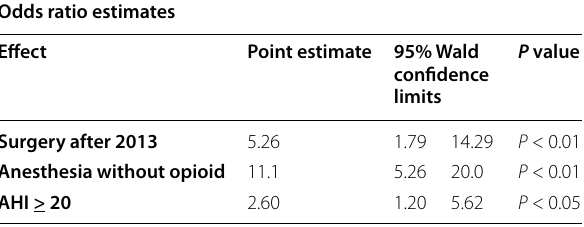
Table 5 Multivariable logistic regression analysis